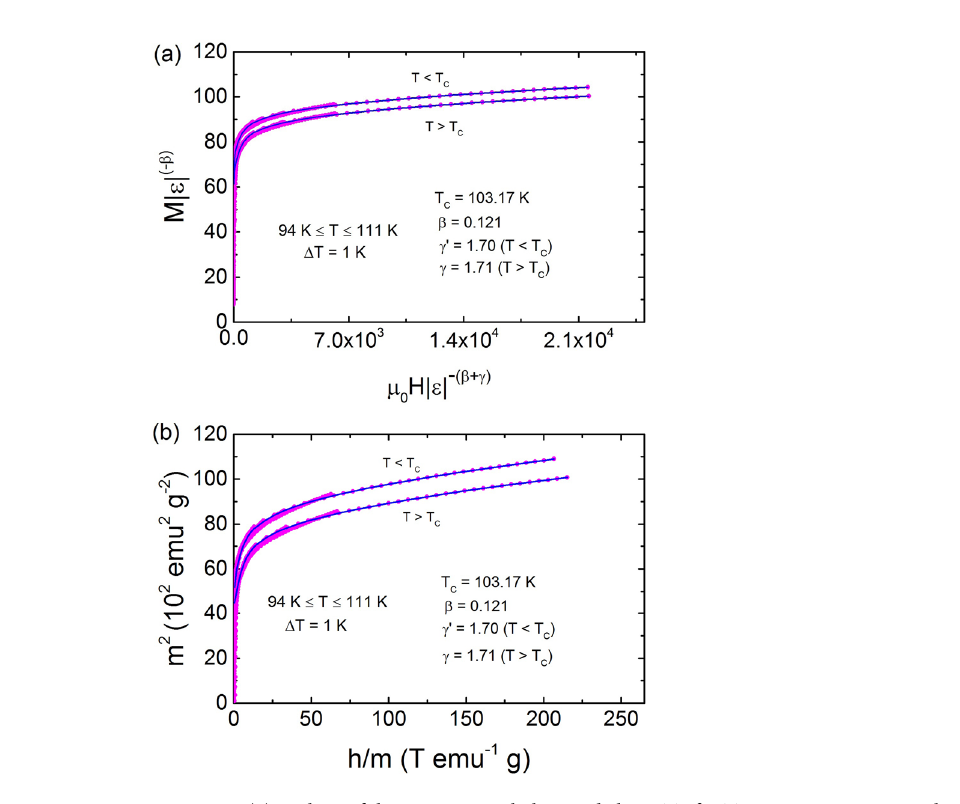
Figure 7. ( a ) Temperature variation of spontaneous magnetization M S (T, 0) (left) and inverse susceptibility χ − (T, 0) (right). ( b ) KF plots for the M S ( dM S ( T )/ dT ) − 1 (left) and χ − drawn using OriginPro 2015 software).